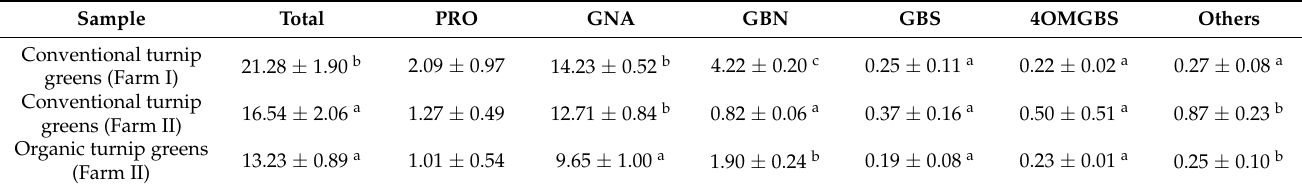
Table 6. Content ( µ mol/g dry weight) of total and individual glucosinolates in turnip greens (mean ± standard deviation).